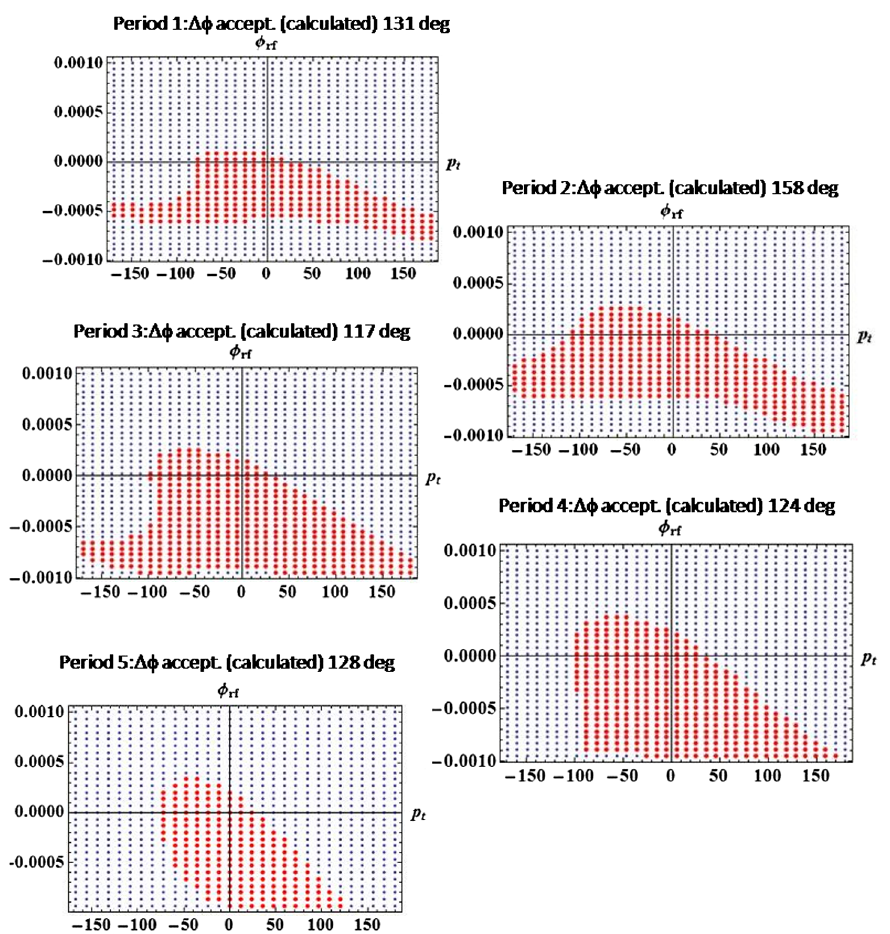
FIG. 7. Longitudinal acceptance of the periods evaluated by solving the longitudinal equation of